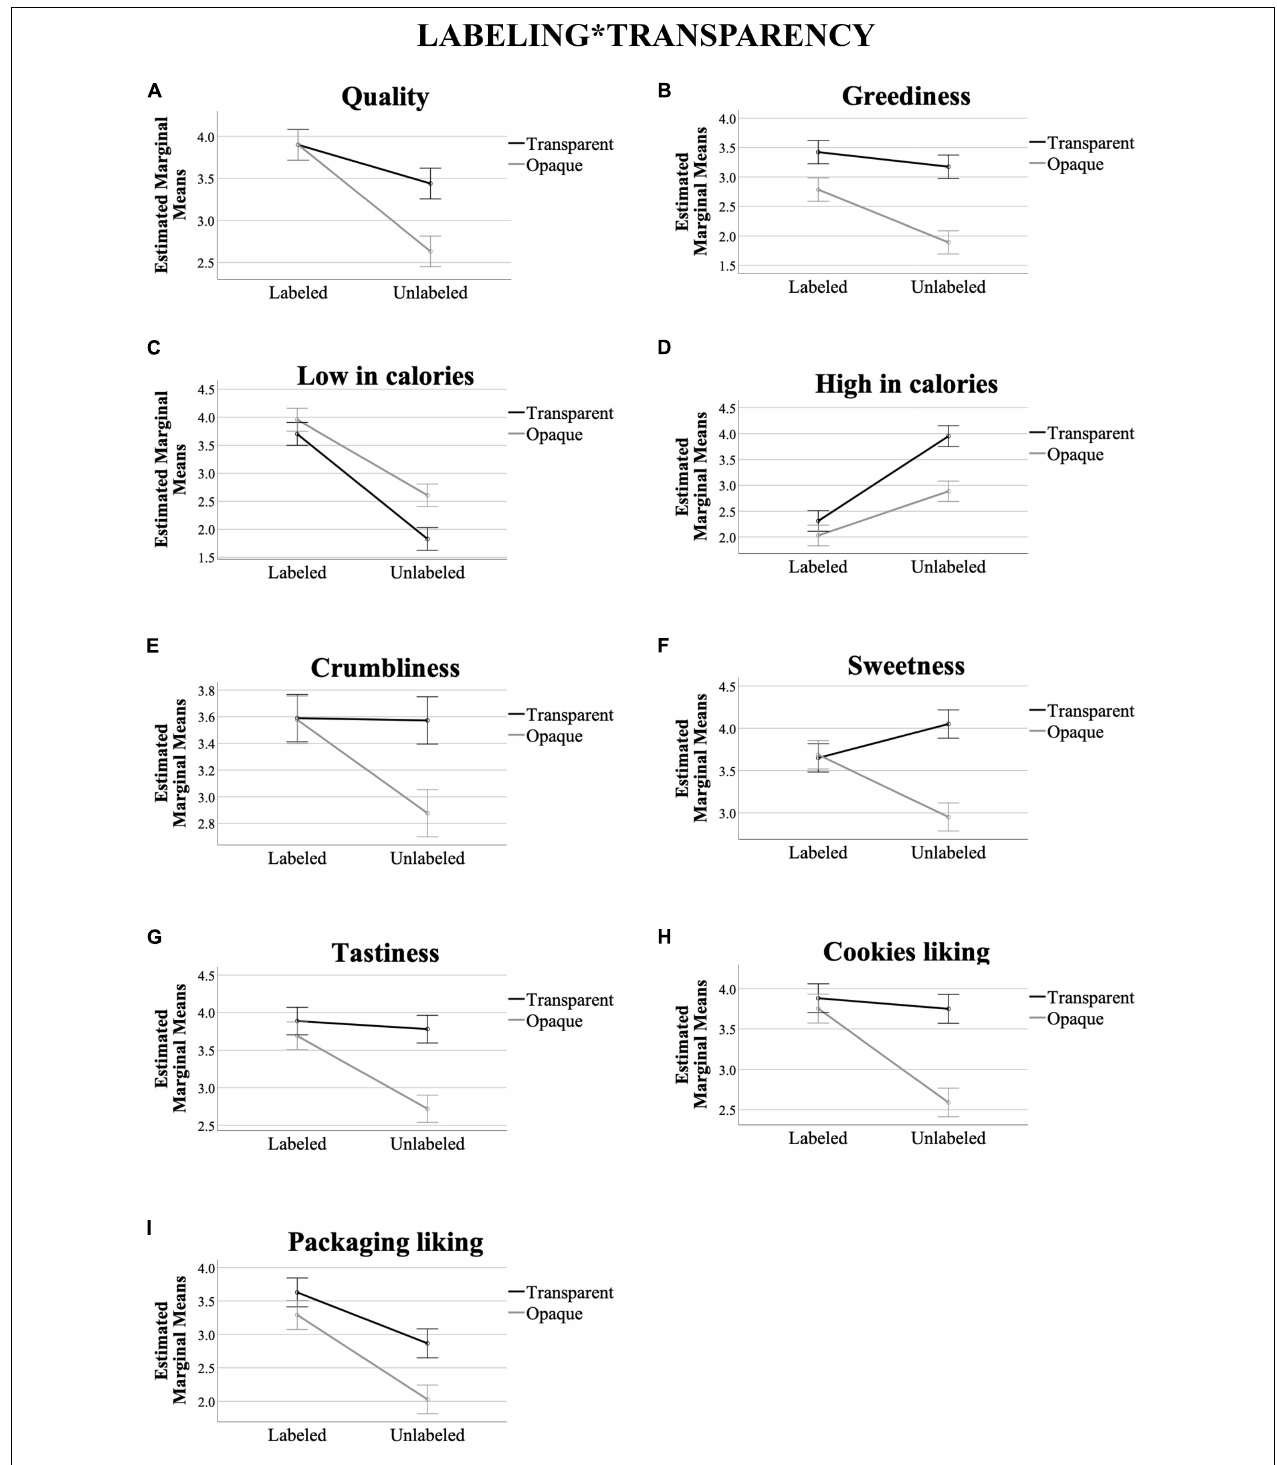
FIGURE 3 | Interaction effects of Labeling*transparency in packaging, across the variables that prompted significant differences at 95% confidence in Table 4 [ (A) Quality, (B) Greediness, (C) Low in calories, (D) High in calories, (E) Crumbliness, (F) Sweetness, (G) Tastiness, (H) Cookies liking, (I) Packaging liking]. Y -axis are the marginal means. X -axis are the labeling conditions. The black (darker) line corresponds to the transparent packaging values, whereas the gray (clearer) line the opaque ones. Error bars show confidence interval at 95%.